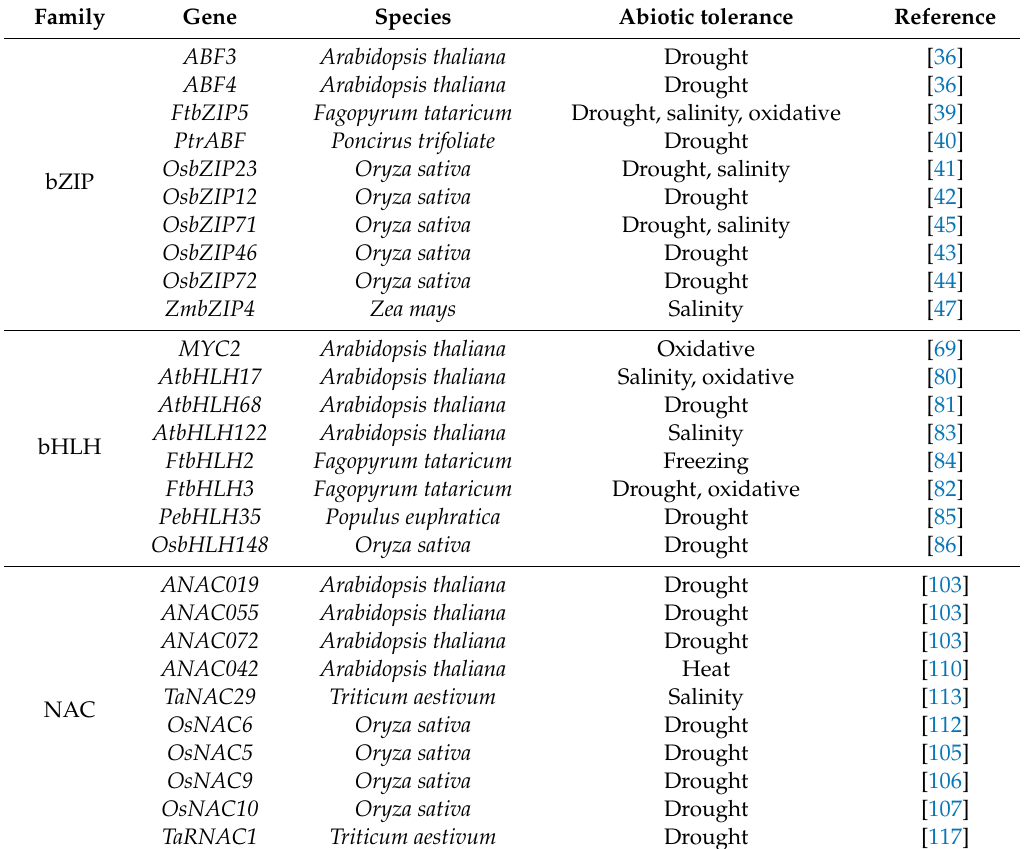
Table 1. Transcription factors that mediate plants tolerance to abiotic